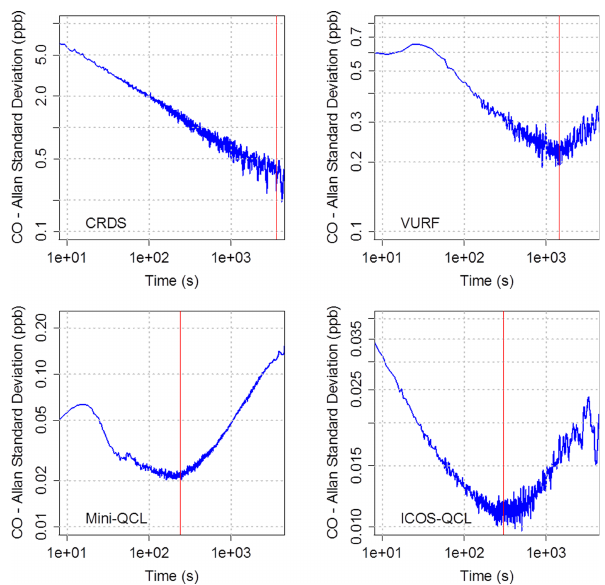
Fig. 3. Allan standard deviation plots for all tested instruments. The lowest Allan standard deviation indicates the optimum averaging time (red vertical lines; CRDS 1h, VURF 24min, Mini-QCL 4min, ICOS-QCL 5min). Please take note of the different y-axis scales of the different panels. The x-axis (in logarithmic scale) spans 60min.